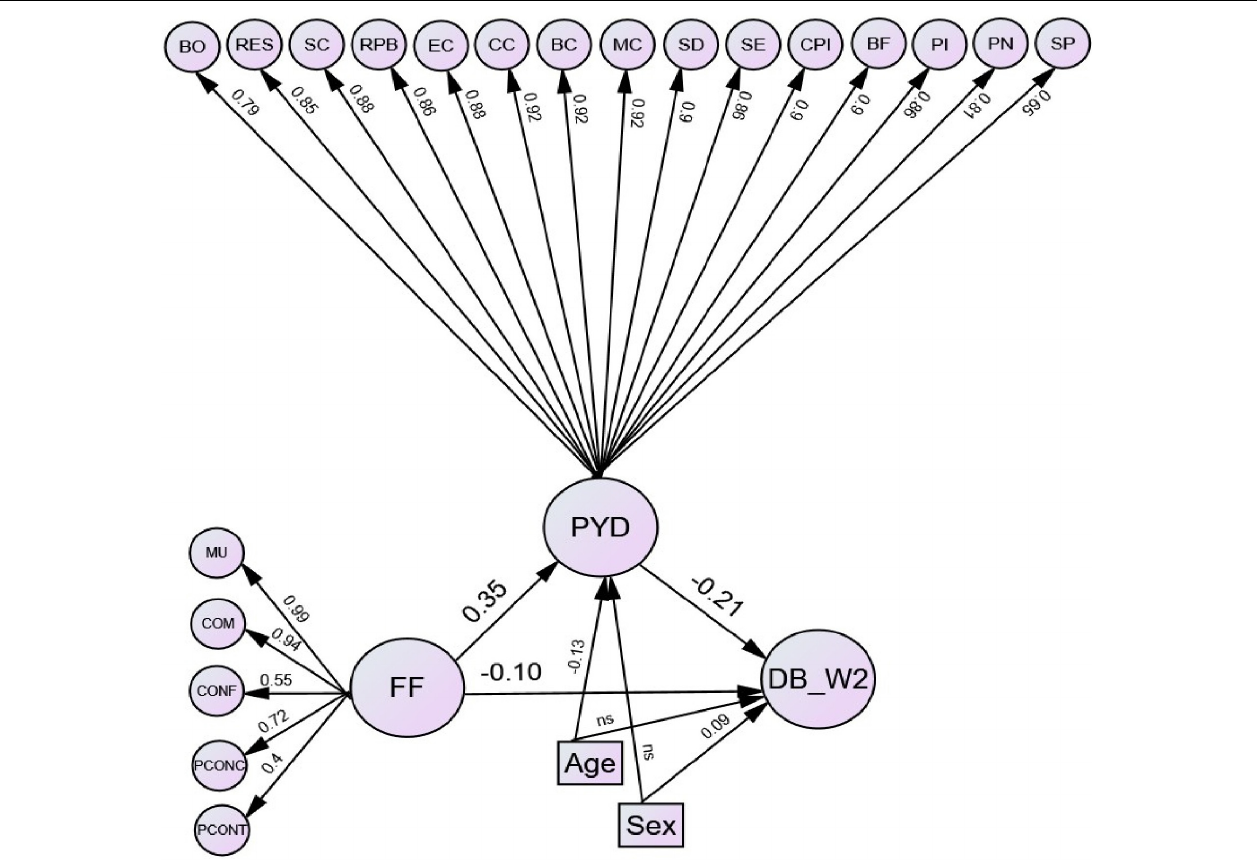
FIGURE 2 | Mediation model of positive youth development at Wave 2 on the path from family functioning at Wave 1 to delinquency at Wave 2 when controlling for age and gender. Note: Standardized estimates are shown in the figure. All paths were significant at 0.05 levels except for the paths from age to delinquency at Wave 2, and from sex to positive youth development at Wave 2. Indicators of all latent variables, correlations among the factors of family functioning, and correlations among covariates are omitted for clarity. DB_W2, delinquency at Wave 2; MU, mutuality; COM, communication; CONF, conflict and harmony; PCONC, parental concern; PCONT, parental control; FF, family functioning; BO, bonding; RES, resilience; SC, social competence; RPB, recognition for positive behavior; EC, emotional competence; CC, cognitive competence; BC, behavioral competence; MC, moral competence; SD, self-determination; SE, self-efficacy; CPI, clear and positive identity; BF, beliefs in the future; PI, prosocial involvement; PN, prosocial norms; SP, spirituality; PYD, positive youth development; Age, age; Sex,